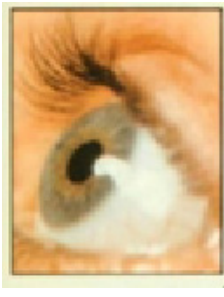
Figure 1. Normal eye.